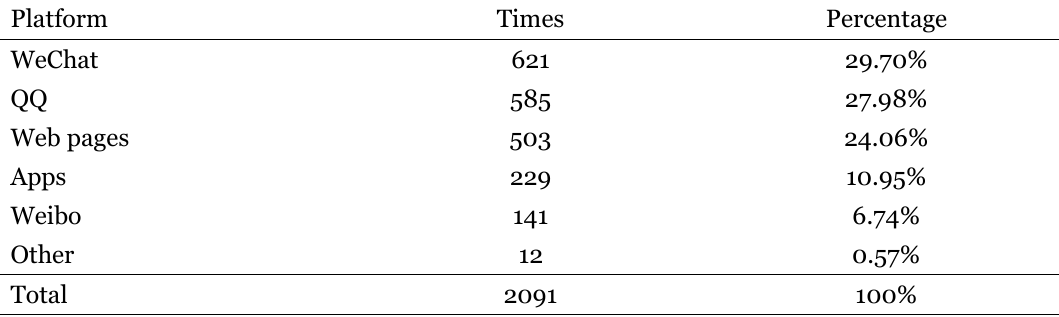
Information Platform Preference